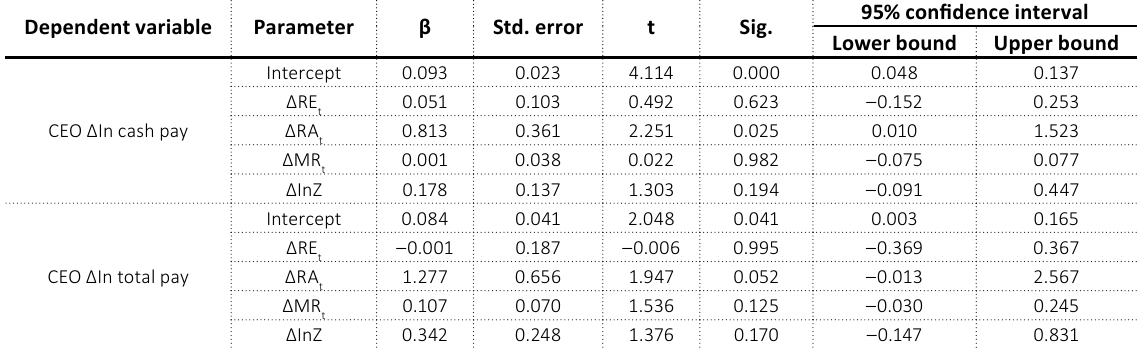
Table 2. R esults of the multivariate analysis for CEO pay Parameter estimates – CEO pay and company